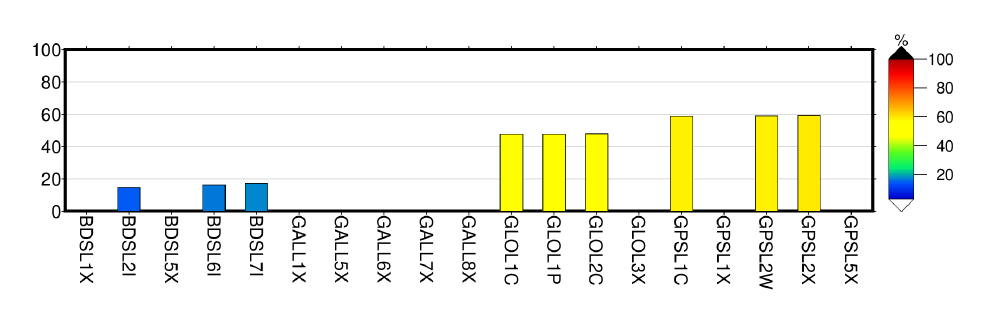
Figure 8. The number of cycle slips improved using the Eccosorb material with respect to not using the Eccosorb microwave-absorbing material. The improvement percentage is an average value for the period January 2021 until the 5th of May 2021 using state-of-the-art Trimble Alloy reference